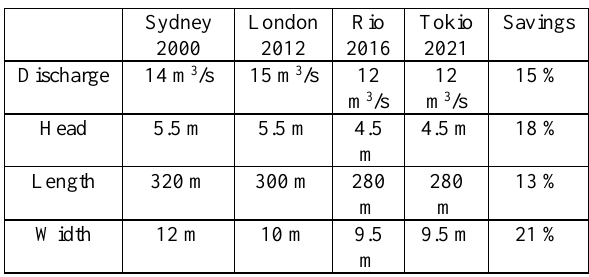
Table 2. Possible savings in construction of Olympic Games white water facilities; similar difficulty of the course from canoeists point of